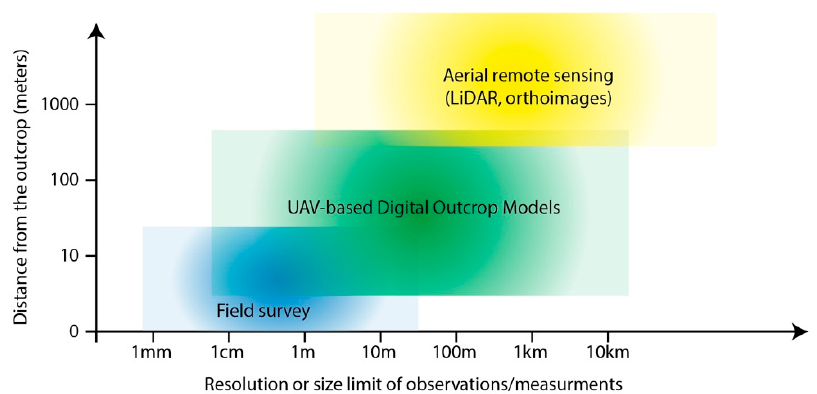
Figure 3. Schematic plots of the possible measurement resolutions achievable by the different techniques of investigation: The traditional field survey (direct-contact), UAV-based Digital Outcrop Models (proximal remote sensing), and aerial LiDAR and orthoimage (distal remote sensing).